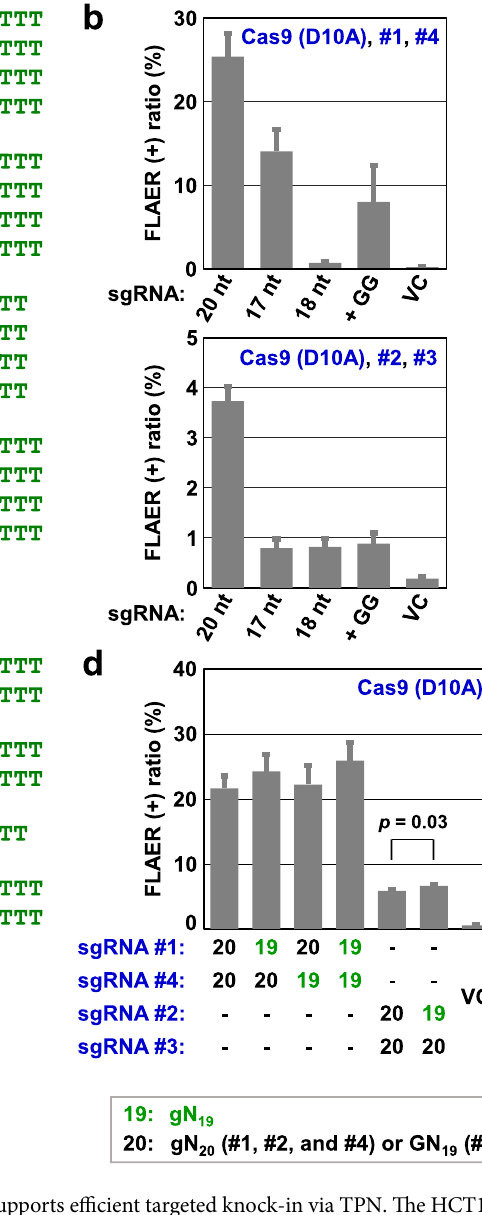
exact processes of DNA recombination elicited by TPN have yet to be elucidated, the experimental results from the present study offer further insights into DNA recombination triggered by TPN. For instance, the truncation of spacers from 20 nt to 17 or 18 nt and the addition of two deoxyguanosines at the 5 ′ ends of spacers often stimulate Cas9 nuclease-based targeted knock-in 22,23 but attenuate TPN-based targeted knock-in, which provides evidence that distinct DNA recombination processes are promoted when different methods for targeted knock-in are used. In addition, we found that nicks placed close to the knock-in site support efficient TPN-based targeted knock-in, which suggests that gene conversion may be one mechanism that plays a major role in TPN-triggered DNA recombination. As reported previously, TPN allows precise targeted knock-in without creating appreciable indels at on- target genomic sites or inducing p53-mediated DNA damage responses 5 . In addition, the use of Cas9 nickases for genome editing is known to drastically reduce indel formation at off-target genomic sites compared with the